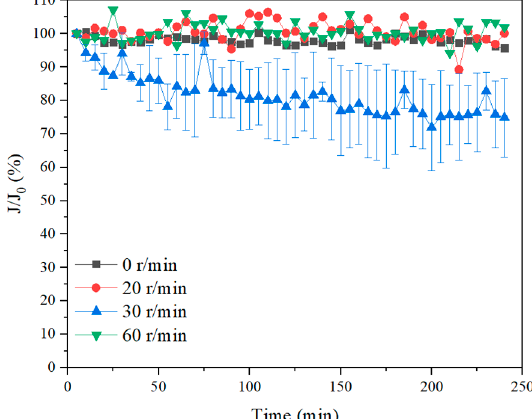
Figure 10. Permeate flux with 30 mg/L coagulant and different rotation speeds in SA solution.